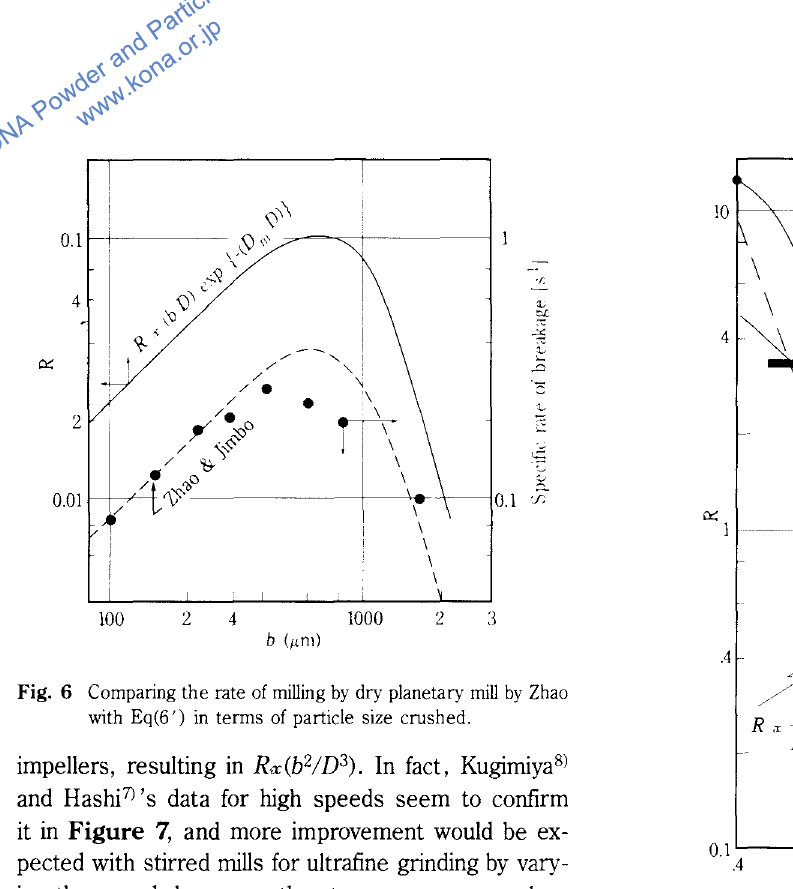
Fig. 7 Effect of colliding speed on the rate of wet stirred milling